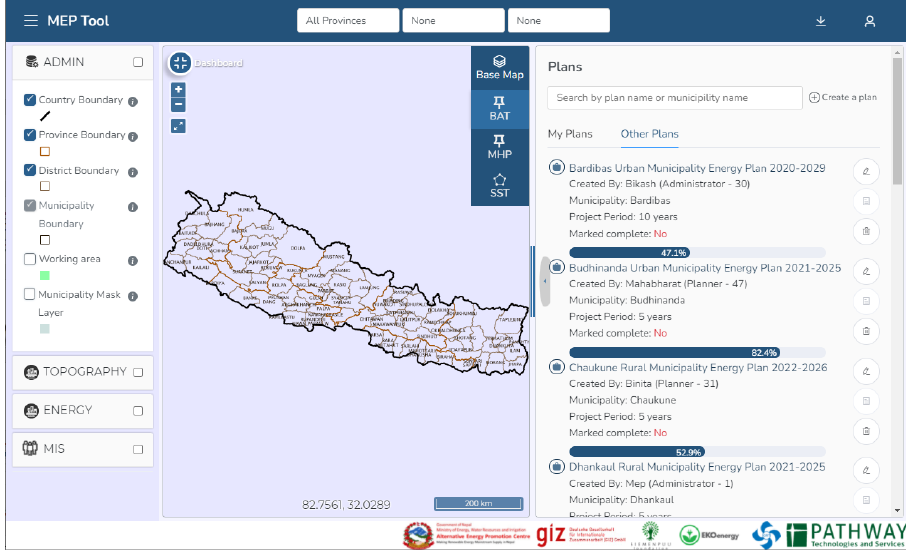
Figure 3. Planning mode of Municipal Energy Planning toolkit.